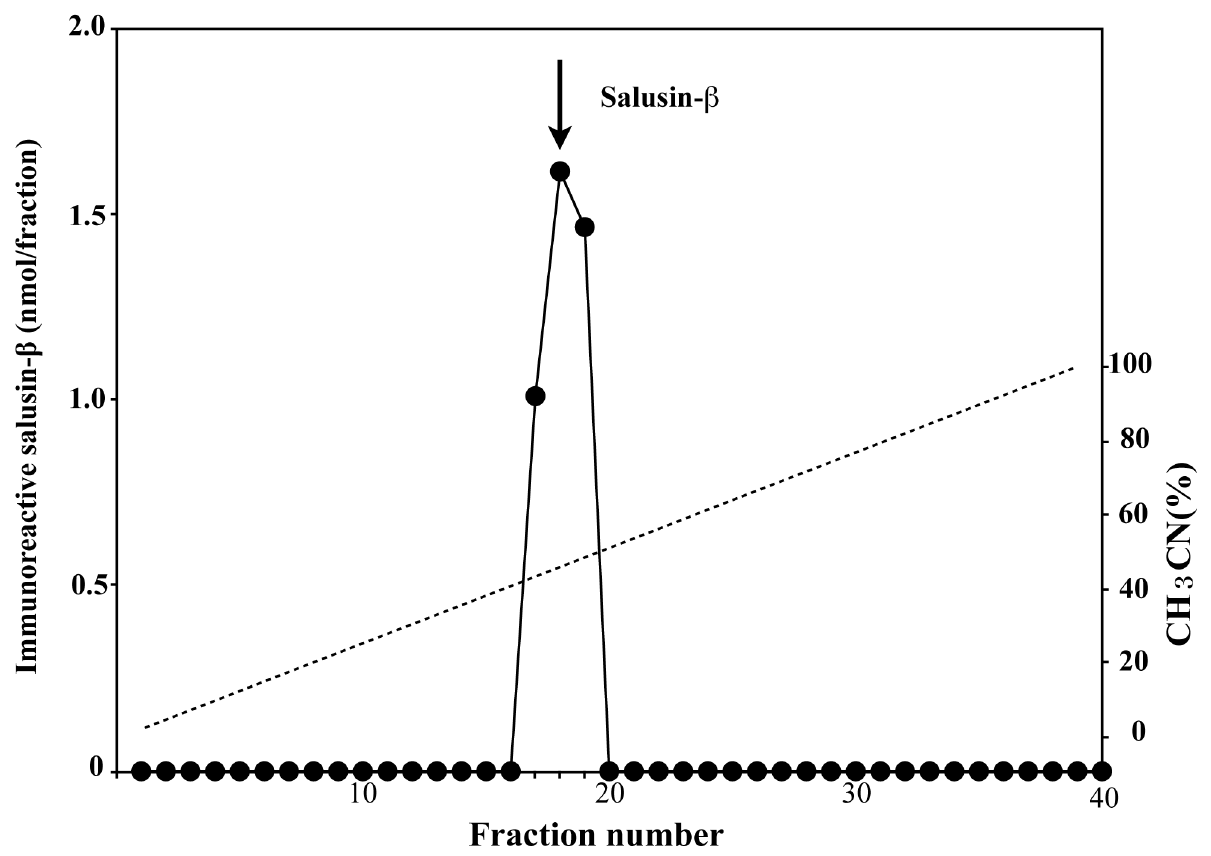
Figure 2. RP-HPLC analysis of salusin-β-like immunoreactivity in human plasma extract. Extracted human plasma and synthetic salusin-β were separated on an RP-HPLC column and the resultant fractions were subjected to salusin-β ELISA. Data points represent salusin-β concentrations of HPLC-fractionated extracted human plasma. The arrow indicates the fraction that contained the elution peak of synthetic